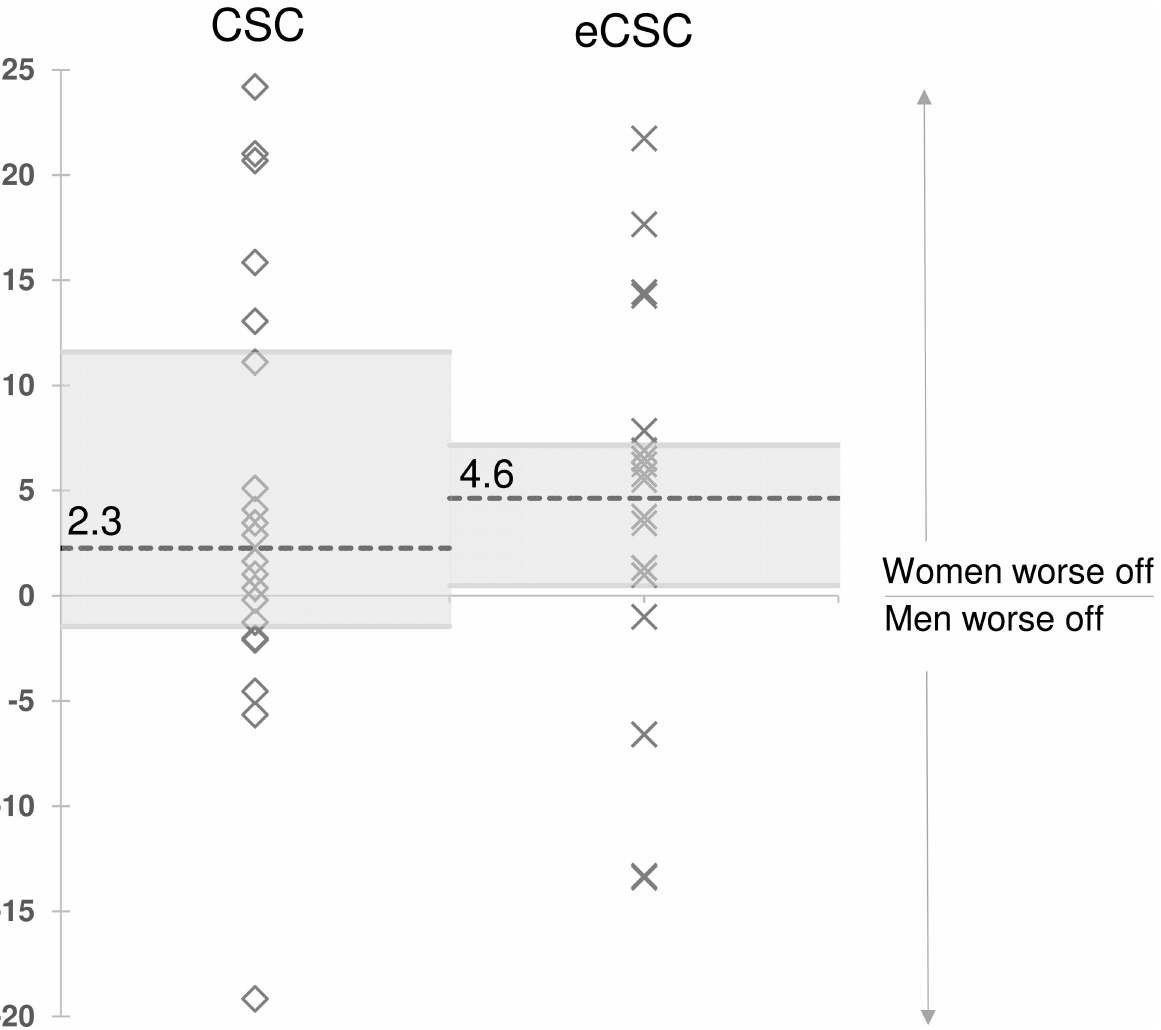
Fig 3. Absolute inequality between women and men in cataract surgical coverage(CSC persons < 6/60 ), and effectivecataract surgical coverage(eCSC persons < 6/60 ) in 20 countries, 2005–2013. Absoluteinequalityis the difference between women and men (e.g. CSC in men–CSCin women); a positive value indicateswomen are worse off. Horizontaldashedlines and labels indicatethe median values of all studies. Grey shadingindicatesthe inter-quartile range (middle50% of studies).